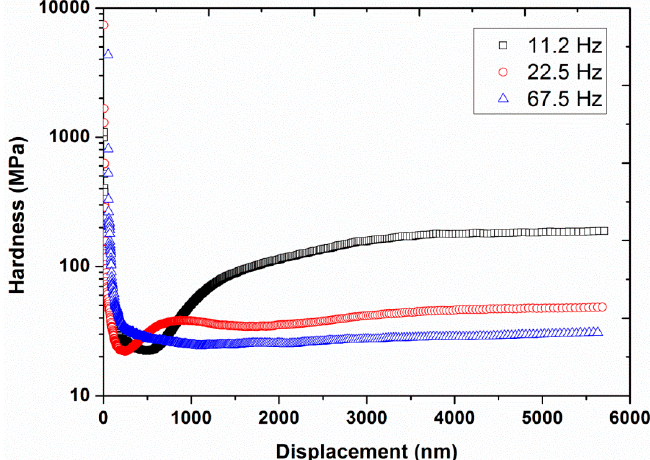
Figure 5. Hardness as a function of displacement for the three different frequencies (11.2, 22.5, and 67.5 Hz) at a vibration amplitude of 2 nm and strain rate of 0.05 s − 1 .